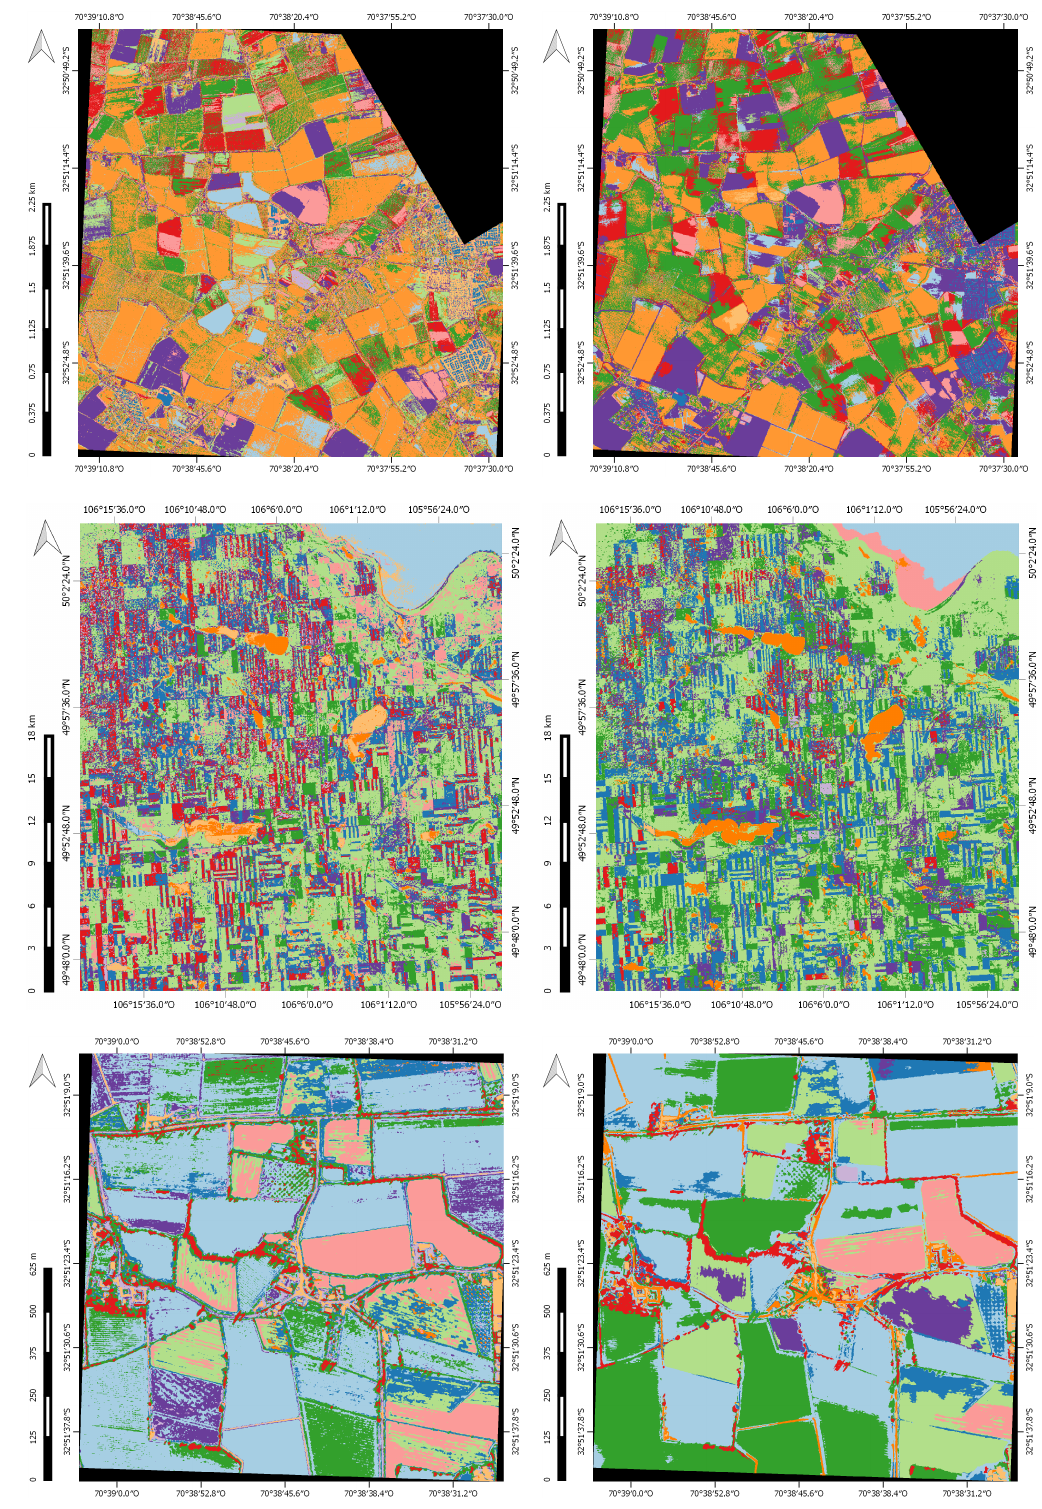
Figure 8. Region-merging methods’ comparison. Co-occurrence in superpixels results in the left column and superpixel characterization in the right column. Upper row: image CHILE2 (10 final spectral clusters). Middle row: image CANADA2 (10 final spectral clusters). Lower row: image CHILE1 (10 final spectral clusters). Colors have no special